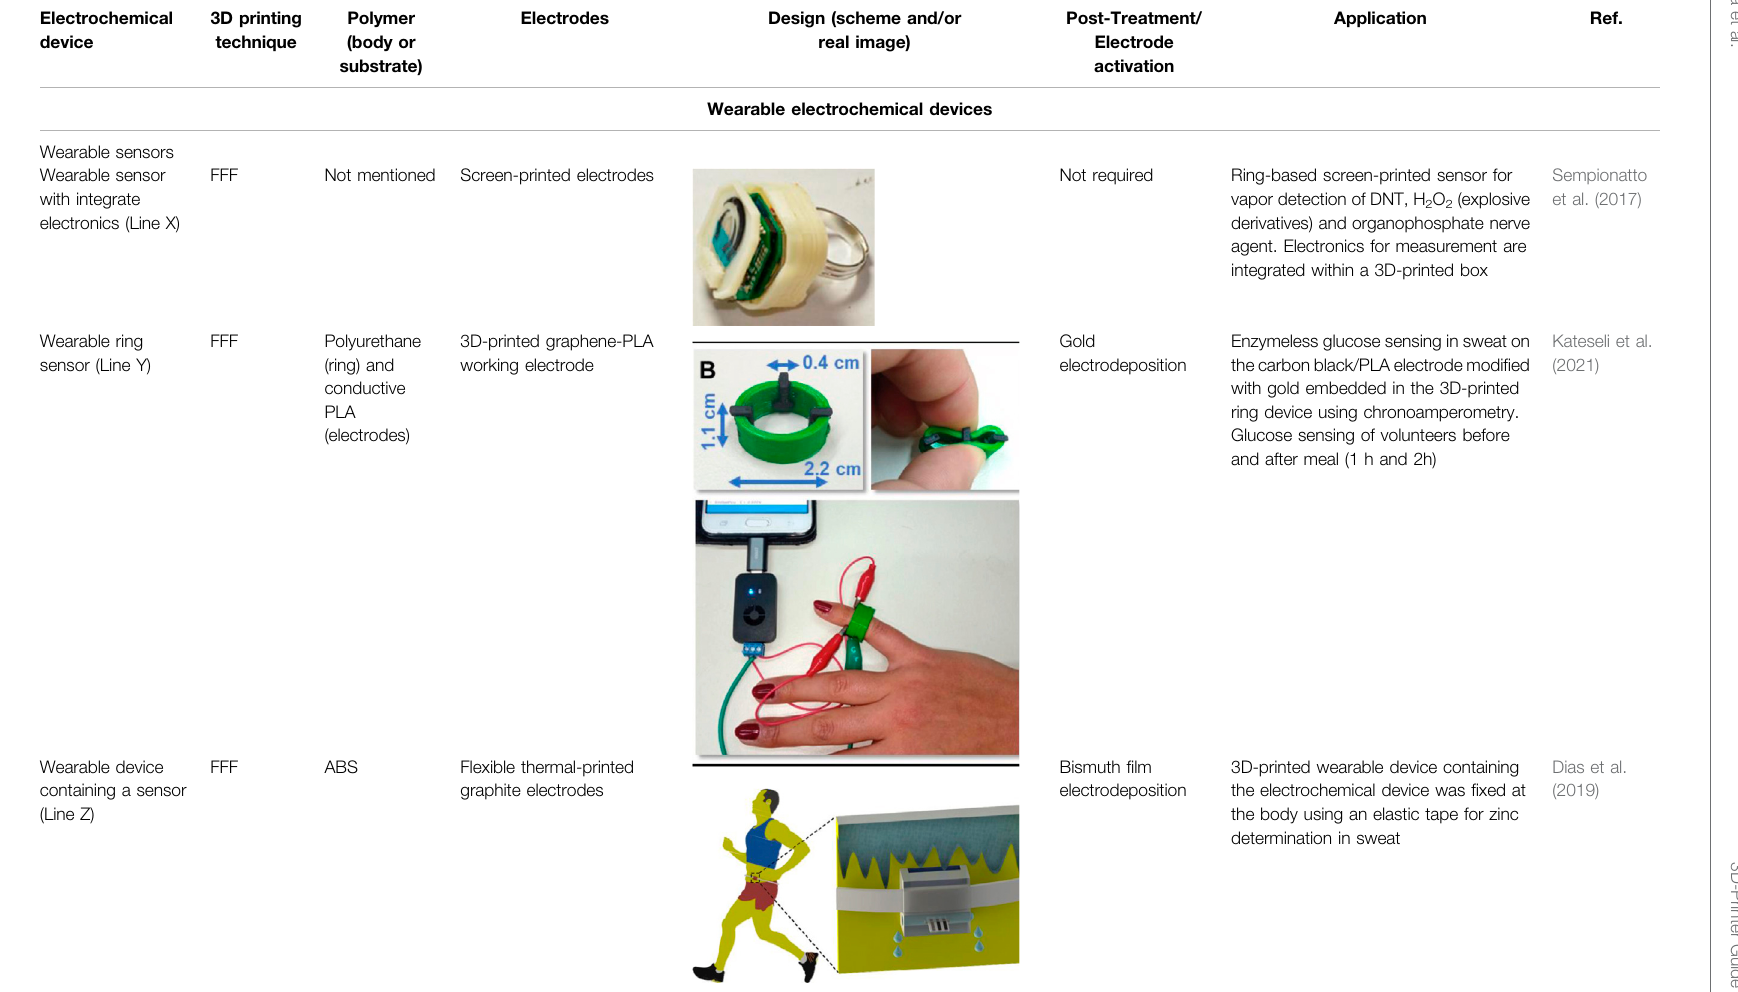
TABLE 2 | ( Continued ) - 3D printed electrochemical cells, including micro fl uidic devices and wearable platforms, their respective printing technique, polymers, and